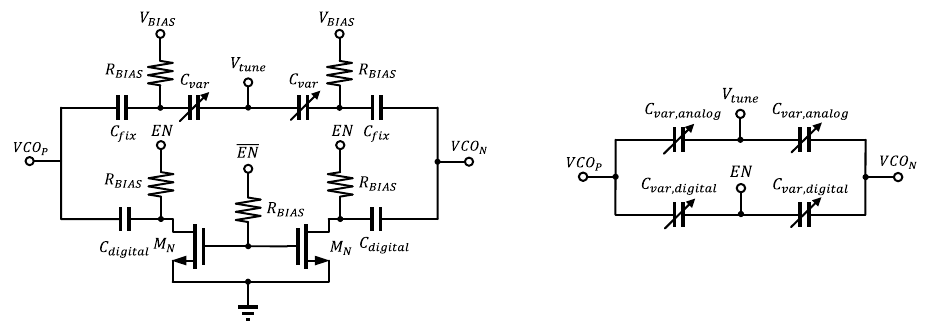
Figure 2. Conceptual schematic of the capacitor arrays: conventional capacitor array ( left ) and proposed varactor-only capacitor array ( right ).